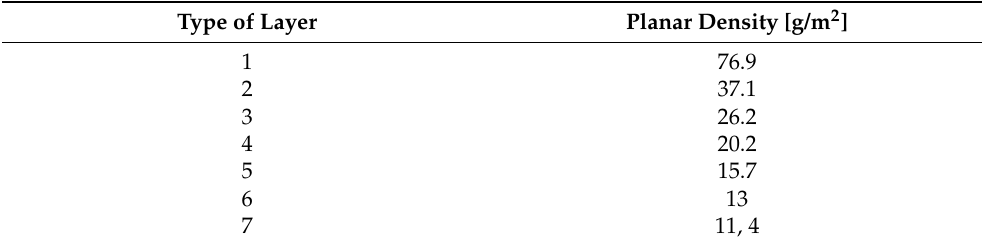
Table 2. Planar density of prepared samples.